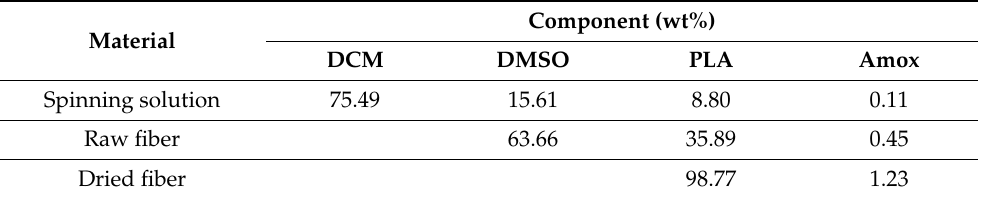
Table 1. Composition of the material at the different stages of the preparation